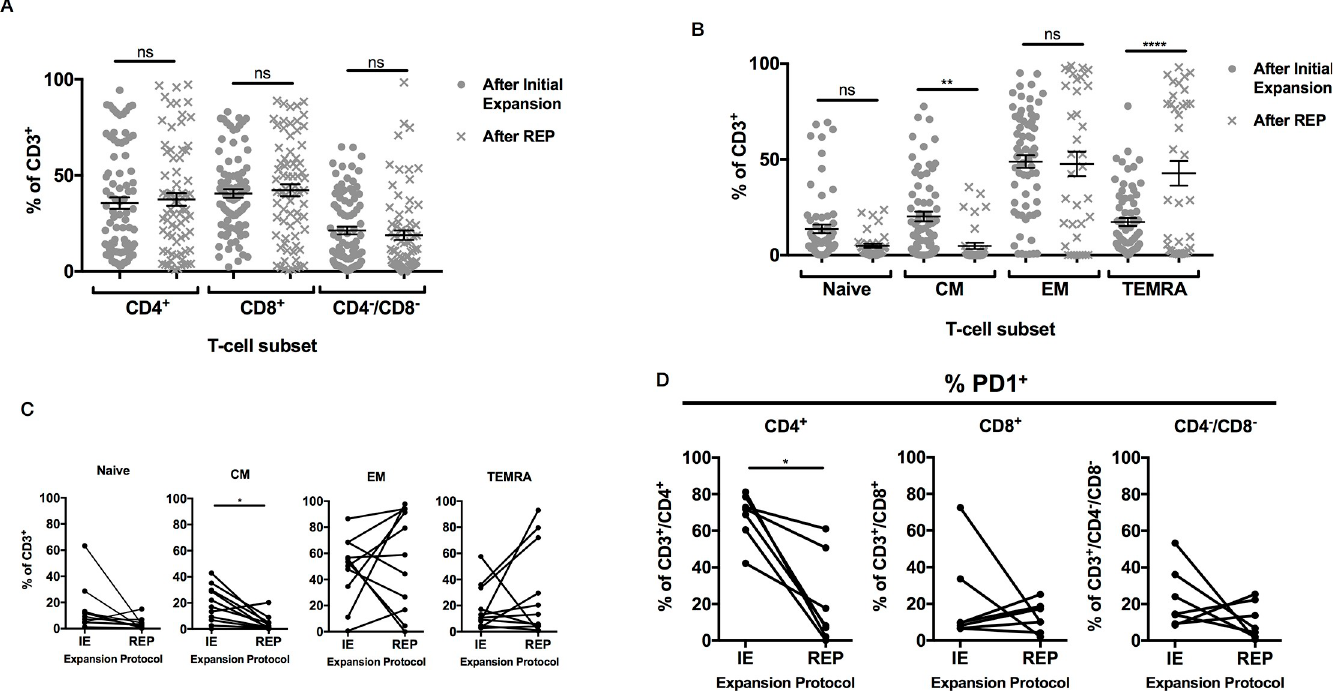
Fig 2. Phenotypic analysis of TILs after initial and REPs. (A) T-cell subsets shown as % of CD3 + cells (n = 75). Statistical comparison by one-way Analysis of Variance (ANOVA) with Sidak’s correction for multiple comparisons. (B) Memory phenotype of T-cells after initial expansion and after the REP (n = 63) using the following criteria: Na ï ve CD62L + /CD45RA + /CD27 + , CM CD62L + /CD45RA - /CD27 + , EM CD62L - /CD45RA - /CD27 - , TEMRA CD62L - /CD45RA + /CD27 - . There was a significant reduction in the proportion of CM cells (p = 0.007) and a significant increase in the proportion of TEMRA cells (p = < 0.0001). Statistical comparison by one-way ANOVA with Sidak’s correction for multiple comparisons. (C) Memory phenotype for paired TIL samples (n = 12) after initial expansion and then following REP. Proportions of CM cells reduced significantly after REP (p = 0.038). Statistical comparison by paired one-way ANOVA with Sidak’s correction for multiple comparisons. (D) PD1 status of paired CD4 + . CD8 + and CD4 - /CD8 - T-cells after initial expansion and then following REP (n = 7). The percentage of CD4 + cells expressing PD1 fell significantly after REP (p = 0.015). Statistical comparison by paired one-way ANOVA with Sidak’s correction for multiple